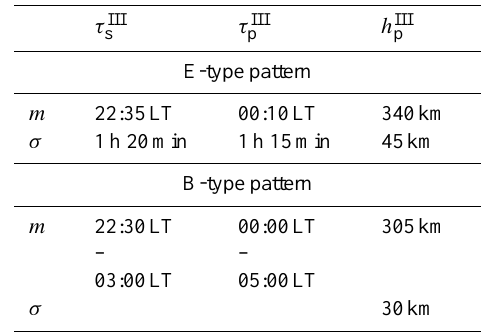
Table 4. Characteristic parameters of the height peak of phase III in the E- and B-type patterns; τ III s denotes the instant at the start of the elevation and τ III p and h III p denote the instant and altitude at the maximum. For each of these parameters, m is the most probable value and σ characterizes the dispersion. Note that, for the B-type pattern, τ III s and τ III p shift within extended time